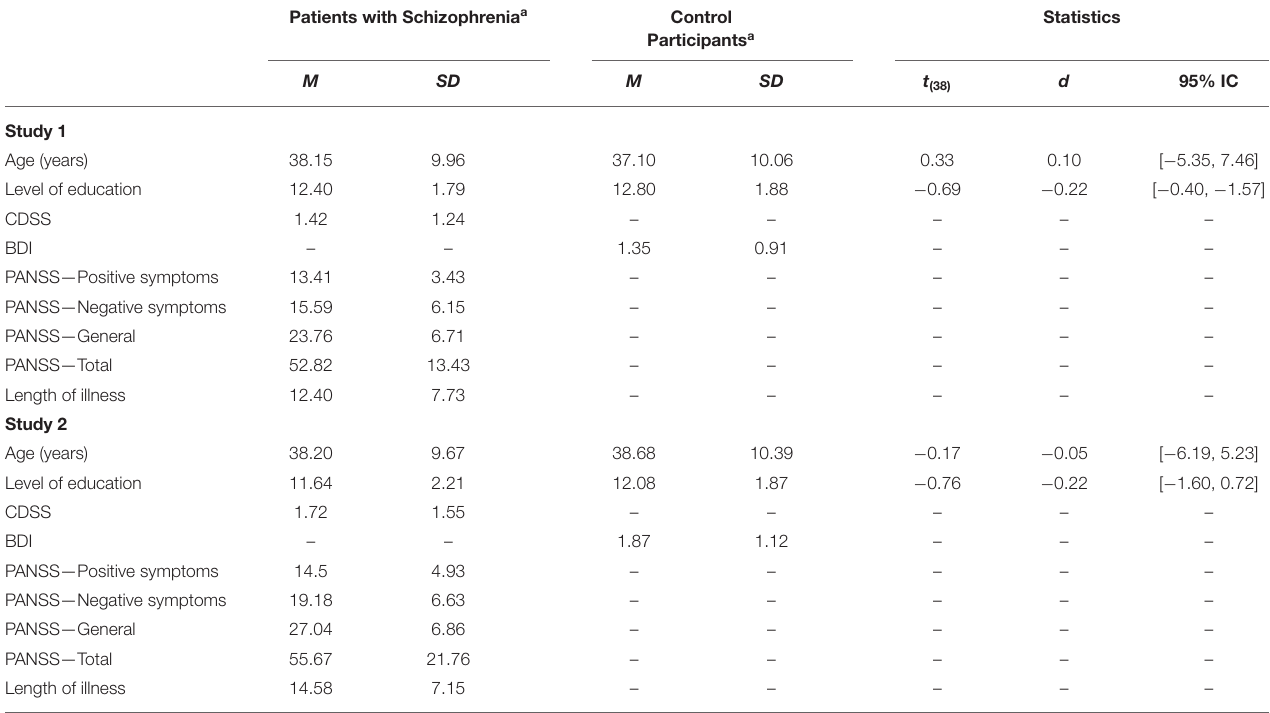
TABLE 1 | Patients with schizophrenia and control participants’ demographic information and clinical measures for study 1 ( n = 40) and study 2 ( n =